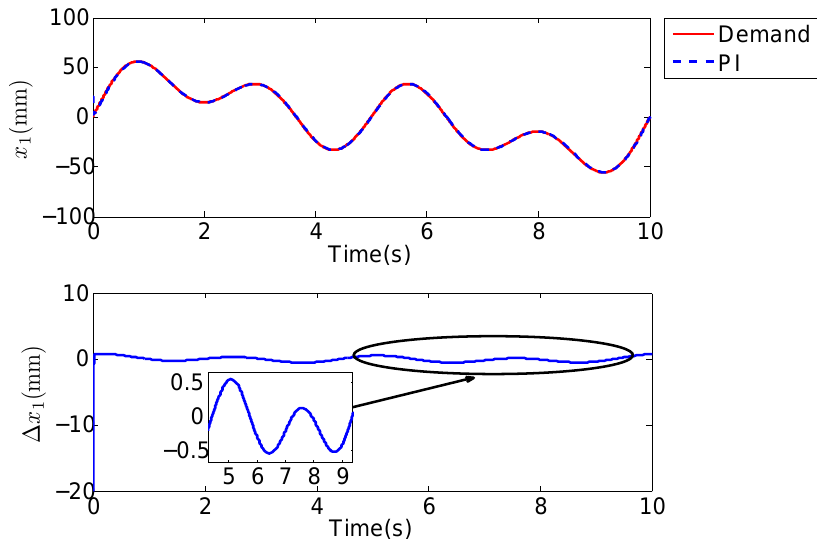
Figure 3. The cylinder position responses x 1 by PI controller with ∆ 2 = ∆ 3 = 0, the demand y d = 25 ( sin ( 0.8 π t ) + sin ( 0.4 π t ) + sin ( 0.2 π t ))